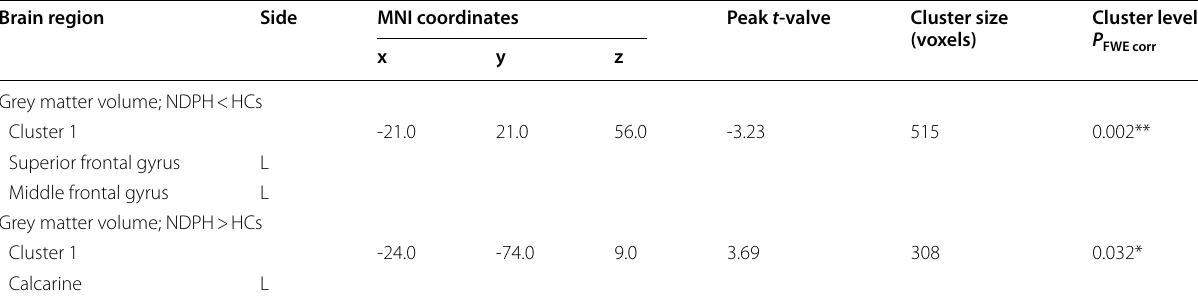
Table 3 Brain region with grey matter volume changes in patients with NDPH